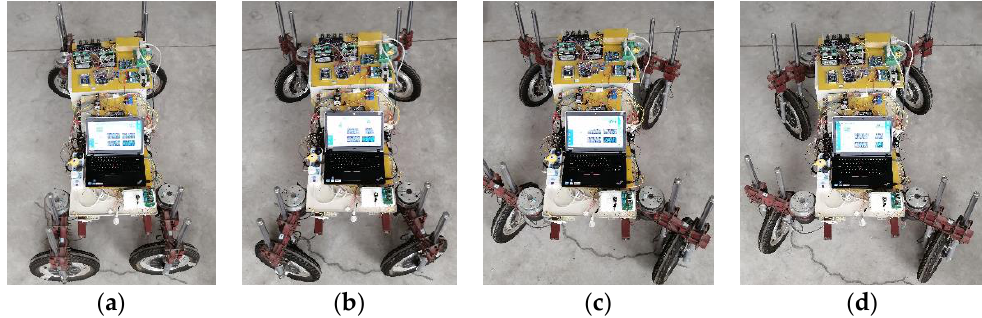
Figure 14. Flexible chassis mode switching on hard pavement: ( a ) cross motion; ( b ) in-place rotation; ( c ) diagonal motion; ( d ) steering motion.